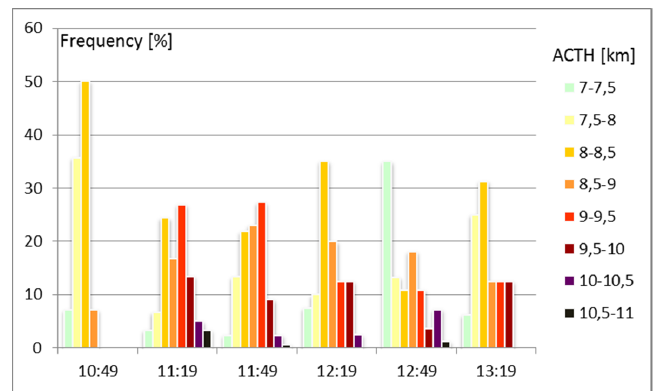
Figure 8. Evolution of ACTH estimated with the parallax method during six MVIRI image acquisitions. The x-axis is UTC time and the y-axis is relative frequency of cloud pixels in ACTH classes binned for each 500 m.